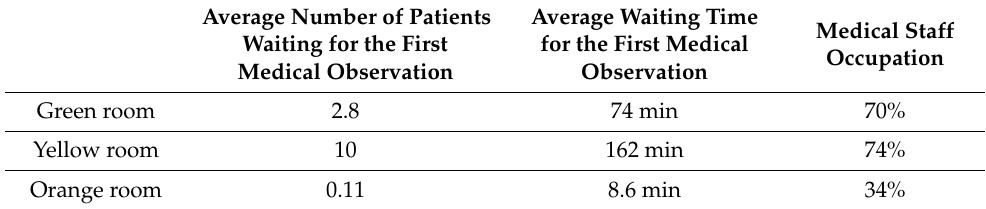
Table 4. Performance of the treatment